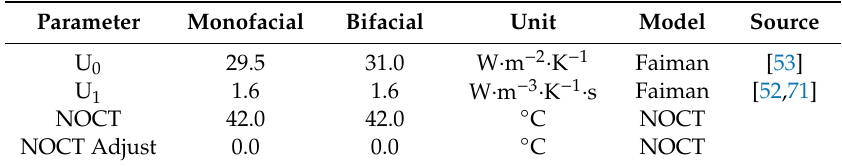
Table A1. Thermal coe ffi cients used in simulations. The NOCT of 42 ◦ C was used because this value gave a comparable thermal response as the selected U 0 / U 1 coe ffi cients with the 1-year of meteorological data used in this study.